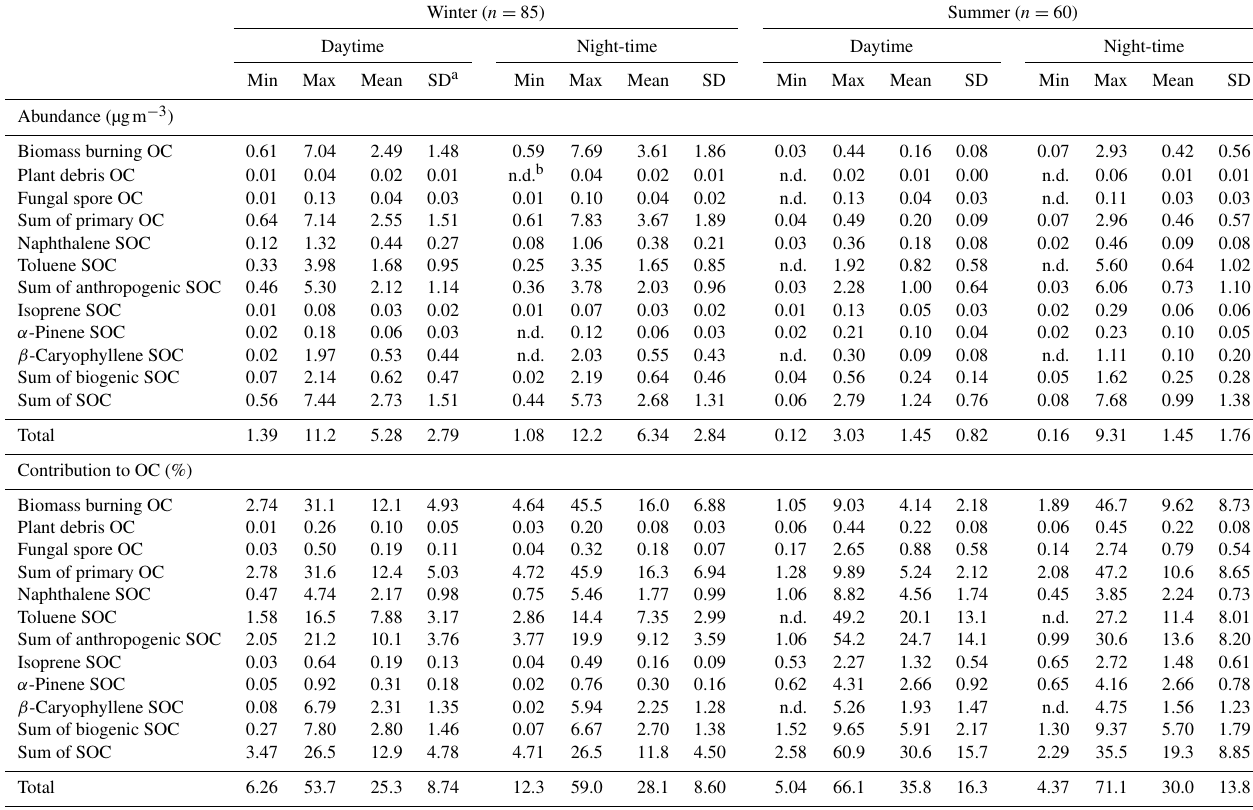
Table 1. Abundance of OC from primary sources – BB-derived OC, plant-debris-derived OC, fungal-spore-derived OC (µgm − 3 ), and secondary formation (biogenic SOC and anthropogenic SOC) – and their contributions to OC (%) in the